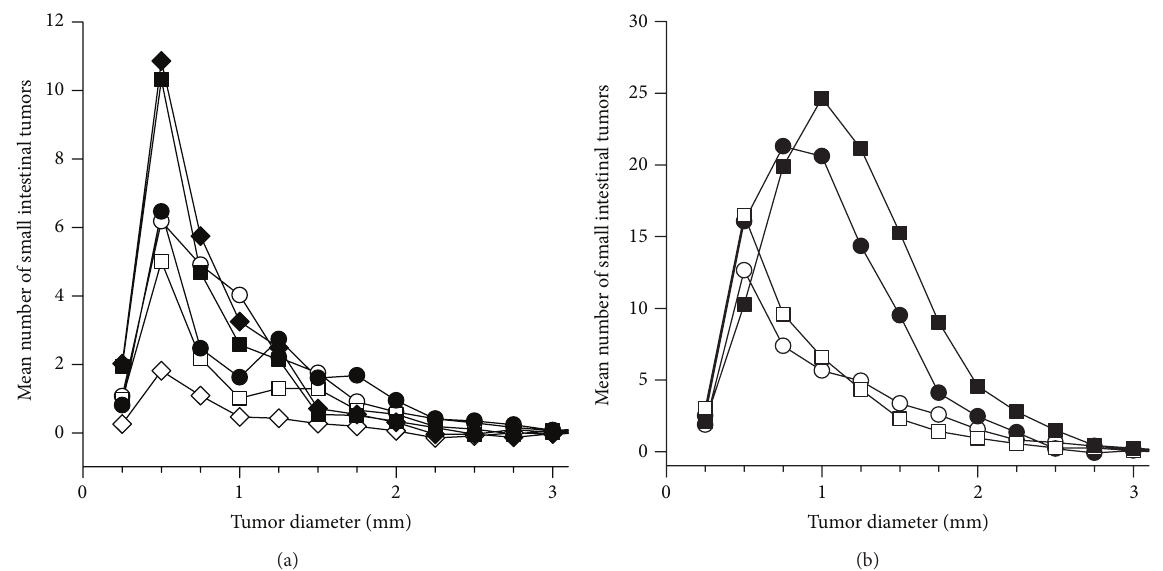
Figure 10: The net effect on tumor size of (a) a 45% fat diet, and (b) of PhIP exposure. (a) The size distribution of small intestinal tumors from untreated pooled female and male Min/+ mice exposed to a 45% fat diet for various periods is calculated by subtracting the mean number of tumors in the mice exposed to a 10% fat diet throughout life from the mean number of tumors in the treatment groups receiving a 45% fat diet for various periods for each tumor size class. (b) The size distribution of small intestinal tumors from pooled female and male Min/+ mice exposed to PhIP is calculated by subtracting the mean number of spontaneous tumors in the mice not exposed to PhIP from the mean number of tumors formed in PhIP-treated mice for each tumor size class. The intervals between the tumor size classes are 0.25 mm. The symbols for the experimental groups are as follows: in (a) 10+10+10 ( I ), 45+10+10 ( ◊ ), 10+45+10 ( ◻ ), 45+45+10 ( e ), 10+10+45 ( X ) 45+45+45 ( ◼ ), and in (b) the dietary groups without PhIP exposure; 45+45+10 ( I ), 45+45+45 ( ◻ ), and the same PhIP-exposed dietary groups with ( e ) or ( ◼ ), respectively. The experimental groups are as explained in the legend to Figure 1. 𝑛 = 44 – 65